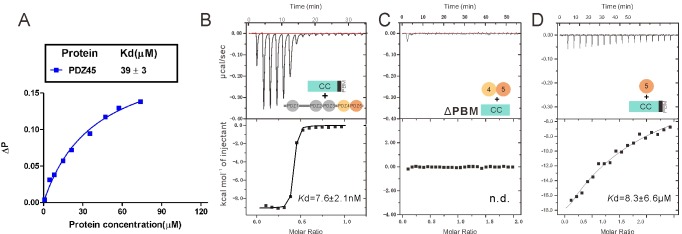
Characterization of the interaction between INAD PDZ45 and NORPA CC-PBM.(A) Fluorescence polarization-based assay measuring the binding affinity between INAD PDZ45 and FITC-labeled NORPA PBM peptide (KTQGKTEFYA). (B) ITC-based measurement showing the binding affinity between the full-length INAD and NORPA CC-PBM. (C) ITC-based measurement showing that deletion of PBM from NORPA CC-PBM completely disrupted its binding to INAD PDZ45. (D) ITC-based measurement showing that isolated PDZ5 has a weak binding to NORPA CC-PBM.